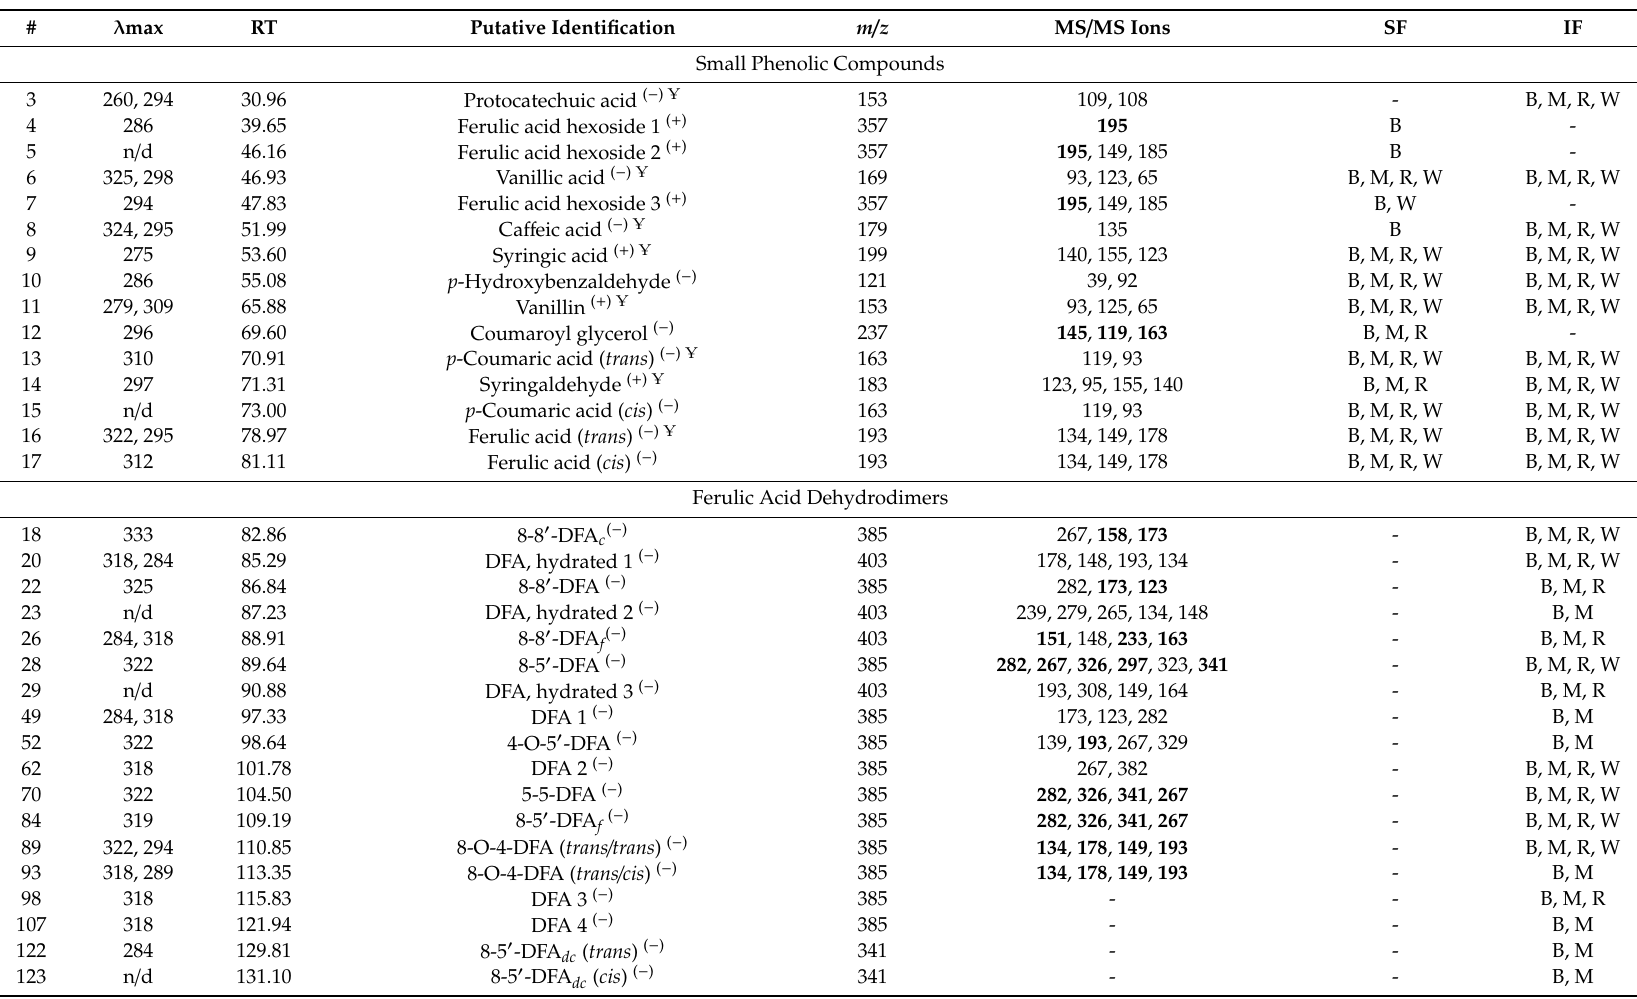
Table 2. Compounds identified by HPLC-DAD-MS / MS (high-performance liquid chromatography coupled with diode array detector and tandem mass spectrometry) in maize (Verdeal de Aperrela), wheat, and rye flours and broa prepared from Verdeal de Aperrela maize flour, in the soluble (SF) and insoluble (IF)